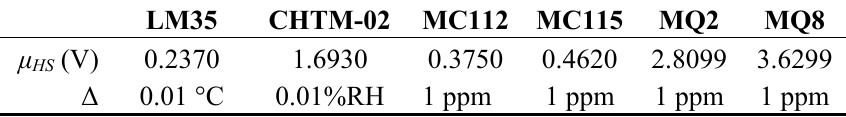
Table 4. Best estimation of true values and base-level values.